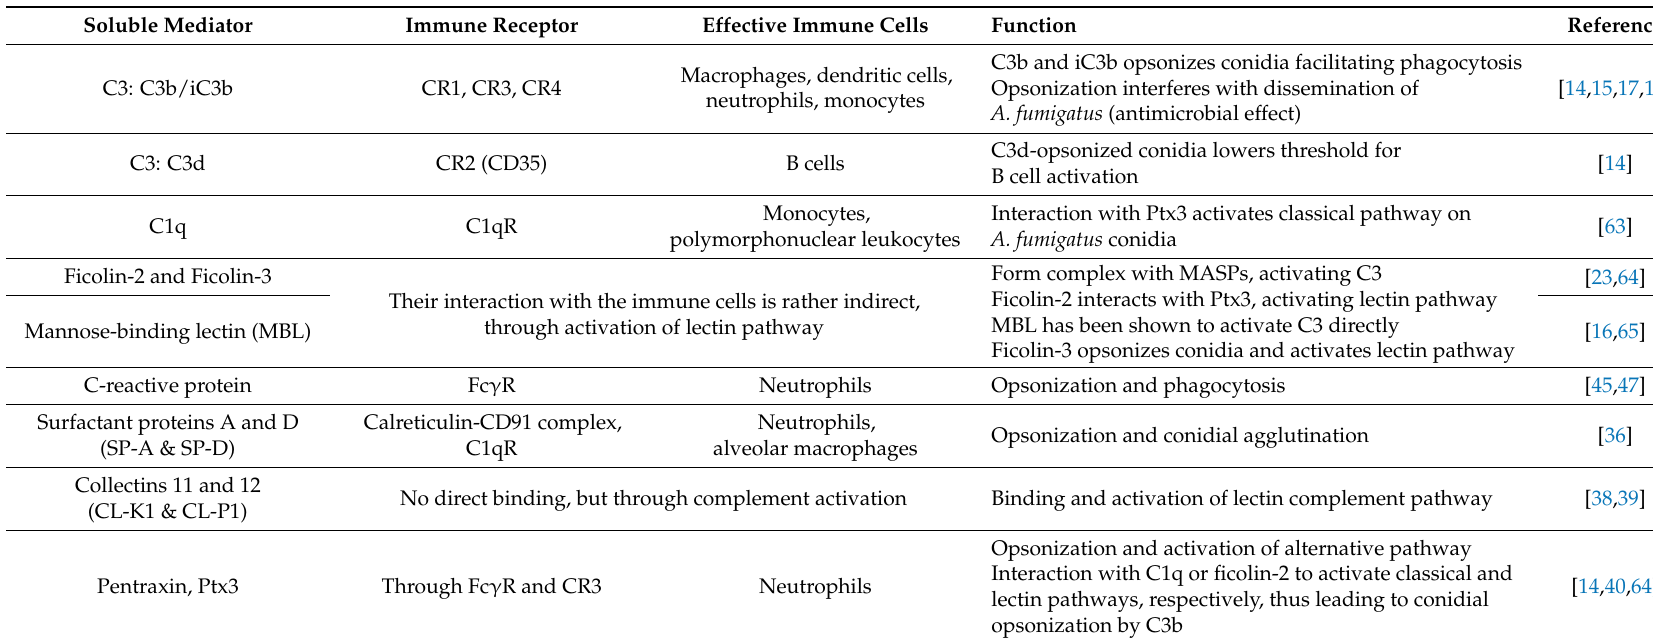
Table 1. Soluble mediators interacting with A. fumigatus conidia, responsive receptors on effector immune cells involved in their recognition and their proven or possible